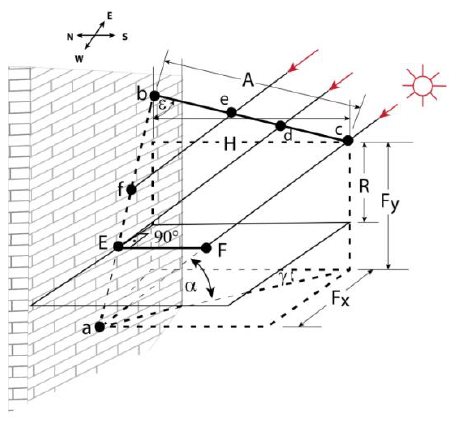
Figure 8. Shadow trajectory of a horizontal pole on a horizontal plate.